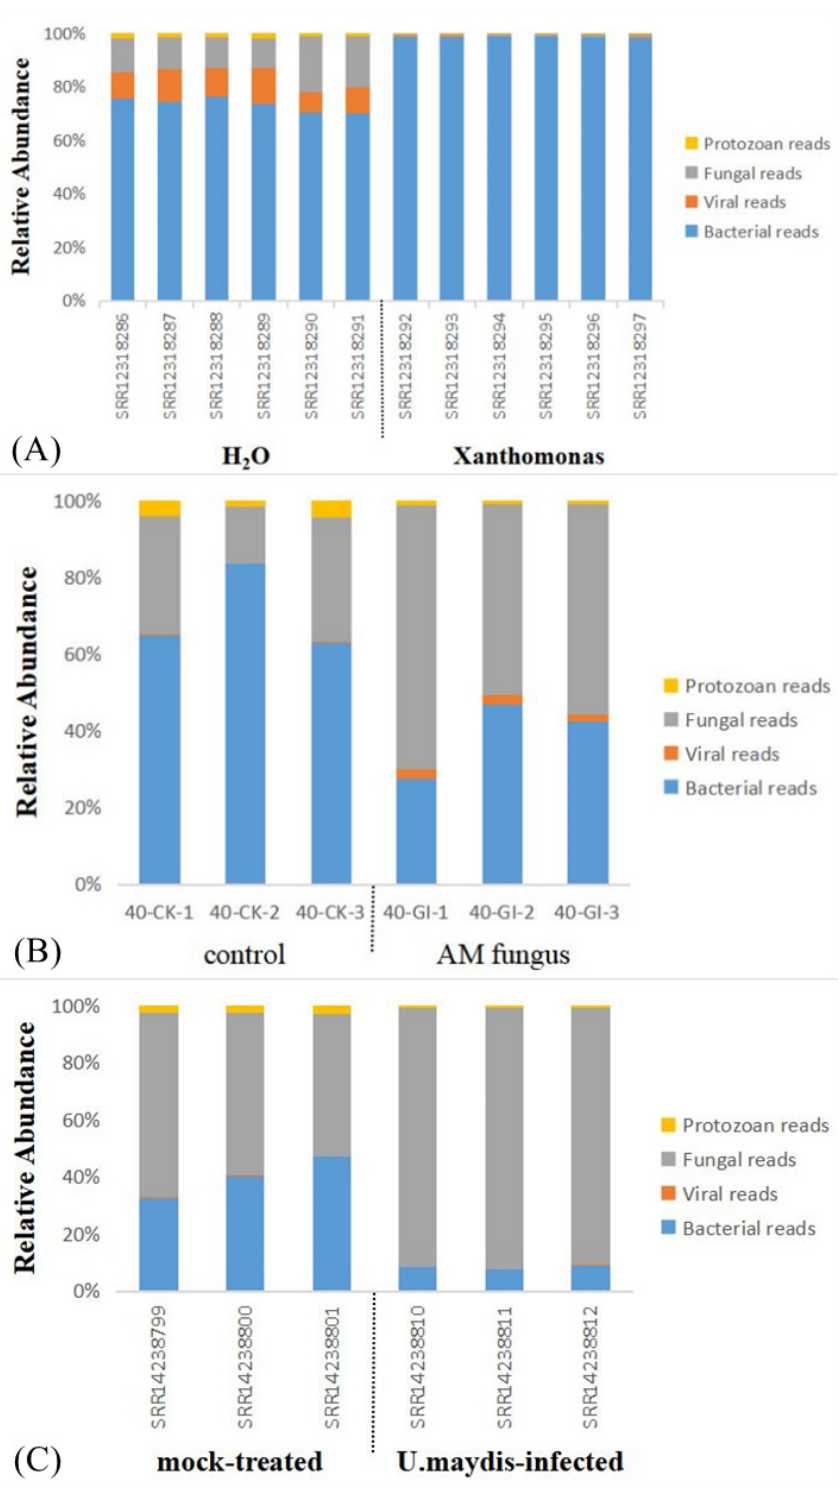
Figure 8. Differences in the microbial composition of plants before and after inoculation with microbes. Note: ( A ) Common soybean inoculation with X. phaseoli pv. phaseoli strain CFBP6546R. The content of bacteria in 6 samples inoculated with X. phaseoli pv. phaseoli strain CFBP6546R increased significantly compared with the 6 samples inoculated with H 2 O. ( B ) Maize root inoculated with AM fungus. The content of fungi in 3 samples inoculated with AM fungus decreased significantly compared with the control. ( C ) Maize seedlings inoculated with U. maydis . The content of fungi in 3 samples inoculated with U. maydis increased significantly compared with 3 mock-treated samples.